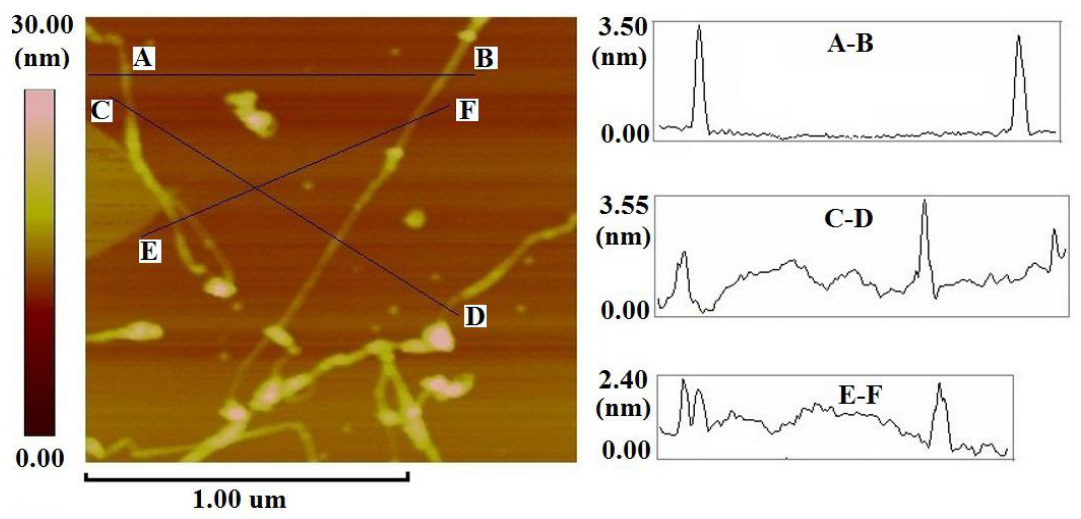
Figure 2. Atomic force microscopy (AFM) image of single-walled carbon nanotubes (SWNTs) complexes of ZnOEP with 76-CoMoCAT on freshly cleaved mica. z-Profiles along A–B, C–D and E–F in the AFM